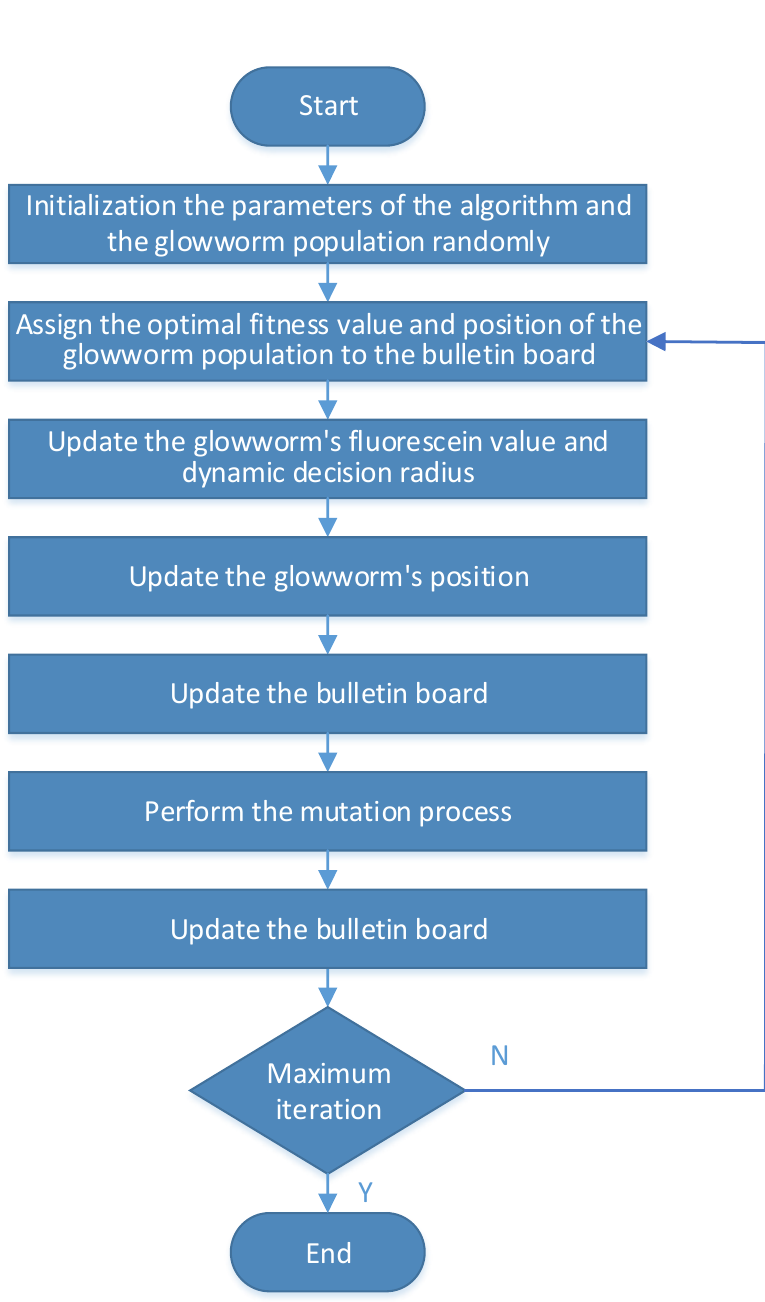
Figure 3. Flowchart of the proposed improved binary glowworm swarm algorithm.